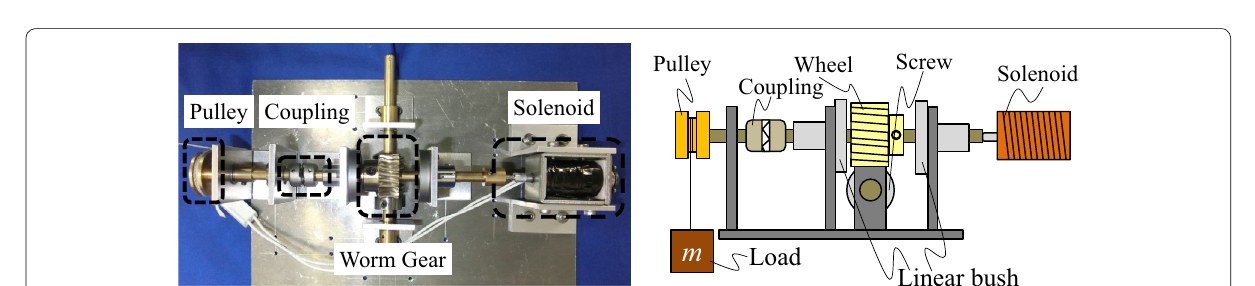
Fig. 6 Experimental setup to observe the backdrivability when the worm wheel is vibrated